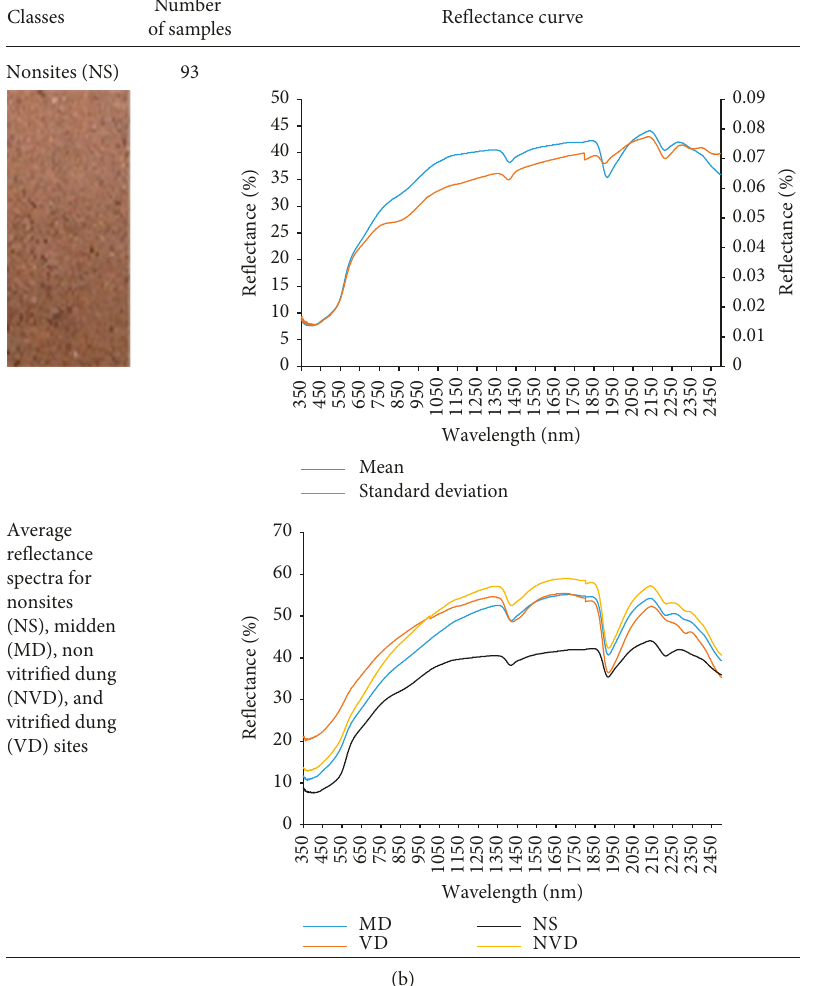
Figure 3: Images and profiles of mean and standard deviation spectra for nonsite (NS), midden (MD), nonvitrified dung (NVD), and vitrified dung (VD) sites. Values for mean spectra are represented on the left axis, while the right axis represents those for the standard